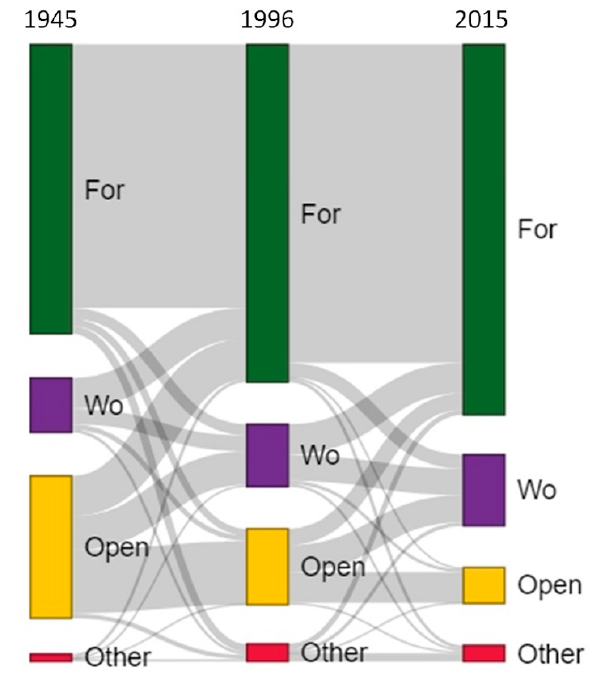
Figure 3. Sankey diagram highlighting the main patterns of LULC changes between the studied years (1945, 1996 and 2015). For: Forest, Wo: Woodland, Open: Open habitat, Other: urban, water and rock land cover classes.